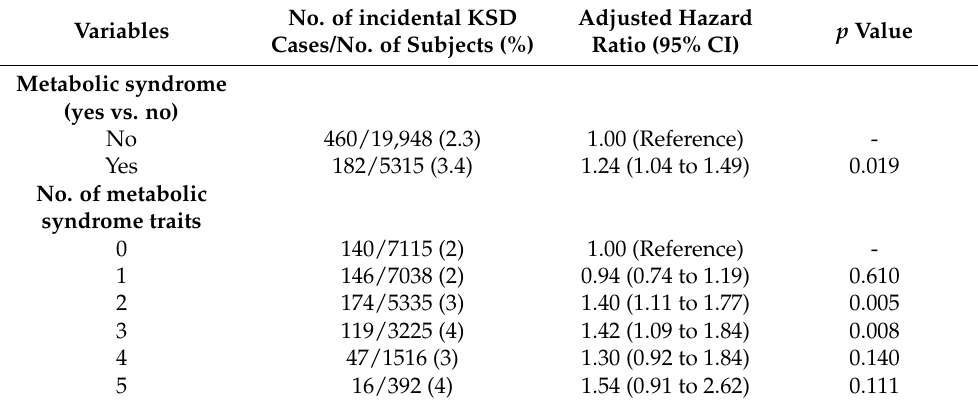
Table 4. Relative risk for incident kidney stone according to the presence of metabolic syndrome. No. of incidental KSD Variables Cases/No. of Subjects (%)